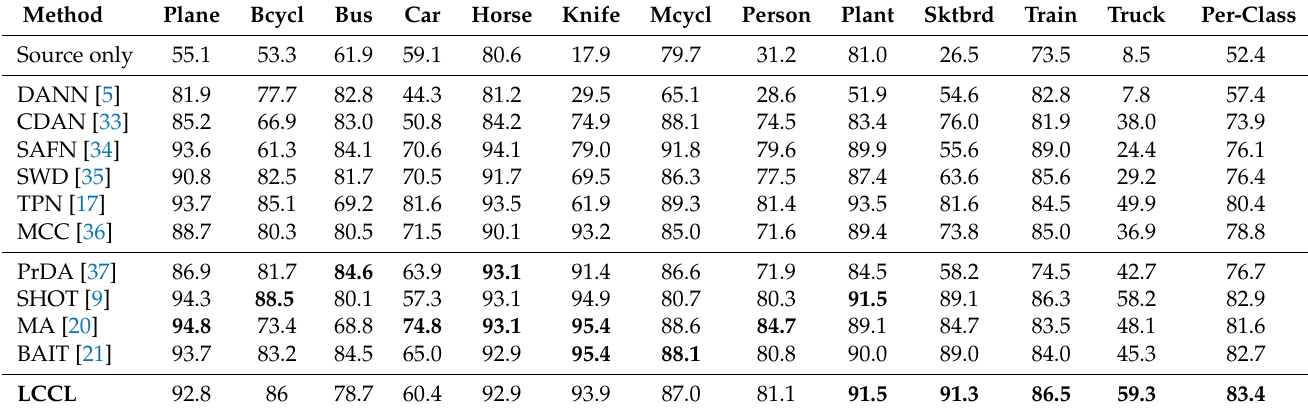
Table 1. Classification accuracies (%) on VisDA-2017 dataset